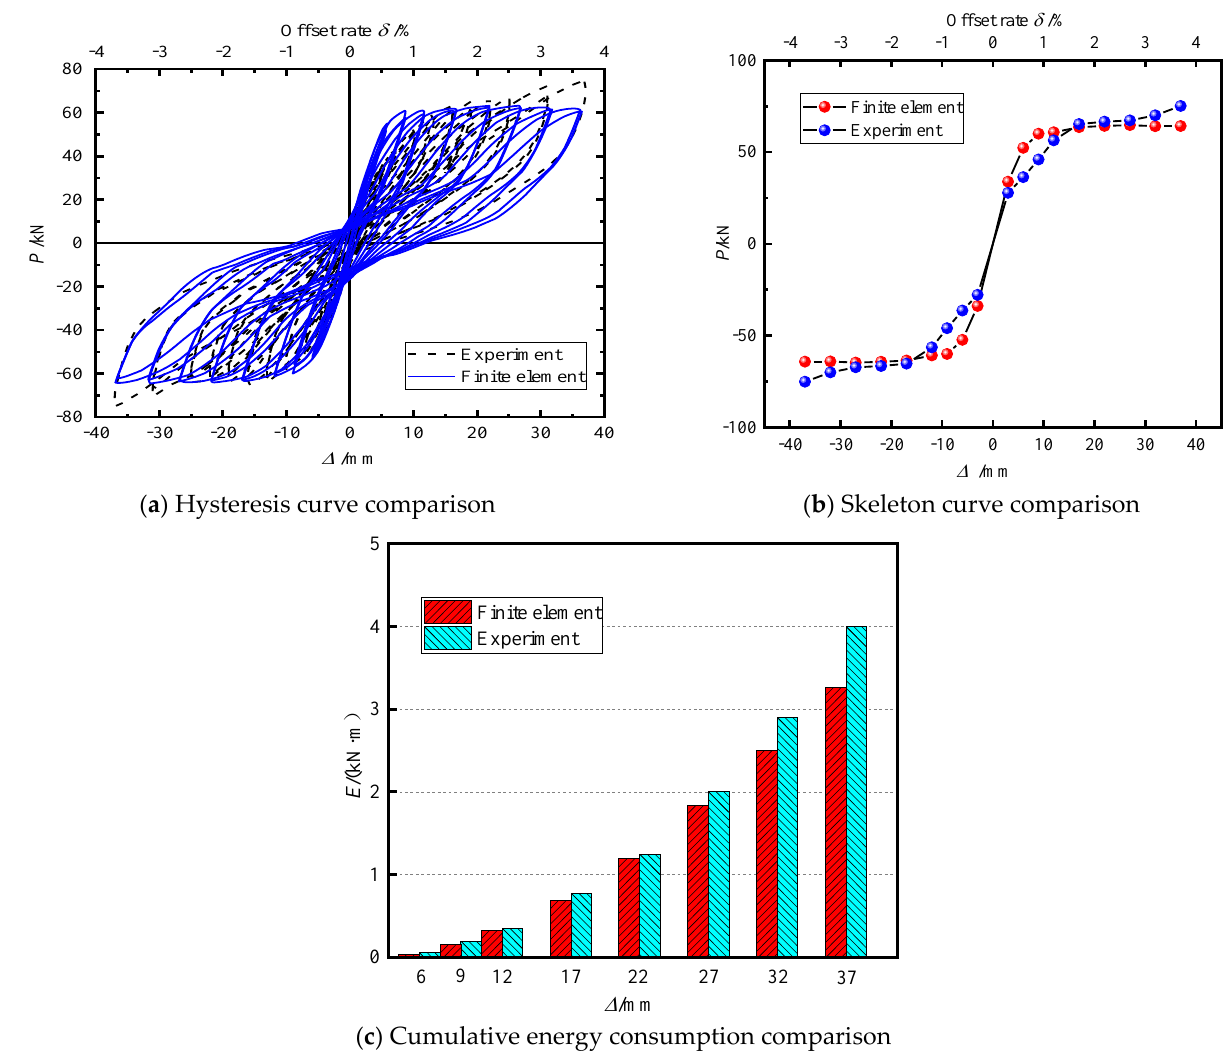
Figure 8. Comparison between experiment and finite element.